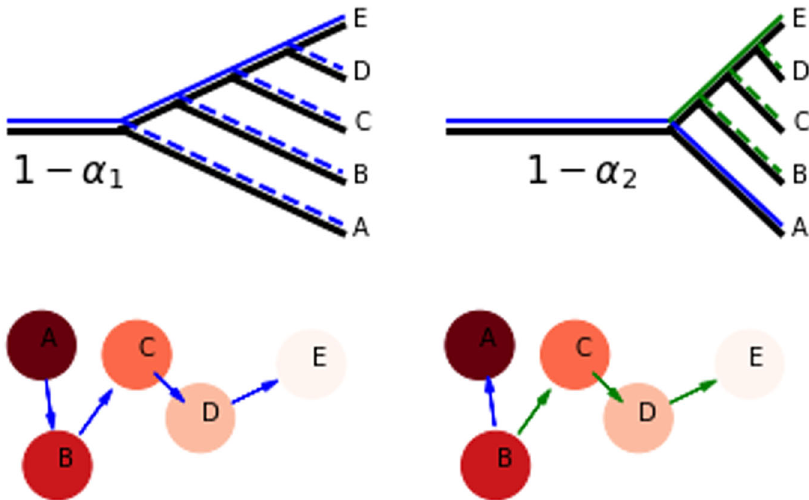
Fig. 5 Different migratory histories for a tree with the same basic structure. On the right side of the fi gure, migratory events occur in a more compressed time